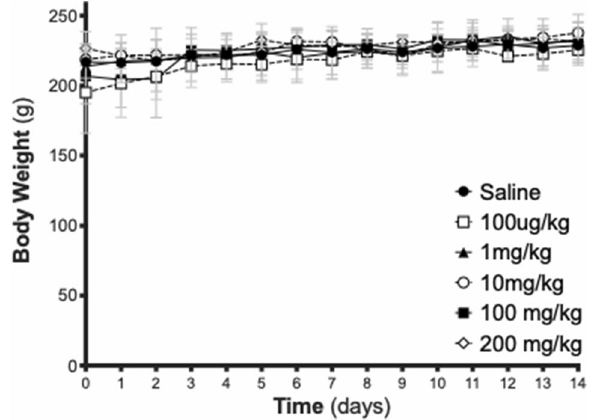
Figure 2. Effect of ELP-VEGF on body weight. Daily body weights of rats are shown after bolus IV injection of ELP-VEGF at increasing doses on Day 0.